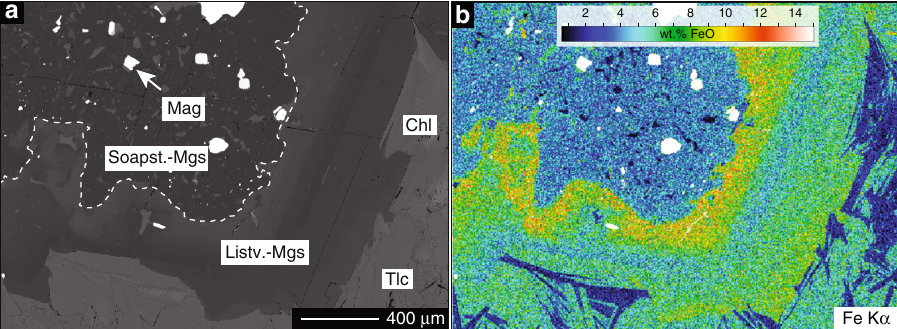
Fig. 5 Compositional zoning in listvenite magnesite BSE image. a and quantitative element map of zoned magnesite b in the listvenite showing the increase in FeO in the euhedral magnesite rim overgrowing a low FeO, magnetite inclusion rich, anhedral magnesite core related to earlier soapstone formation